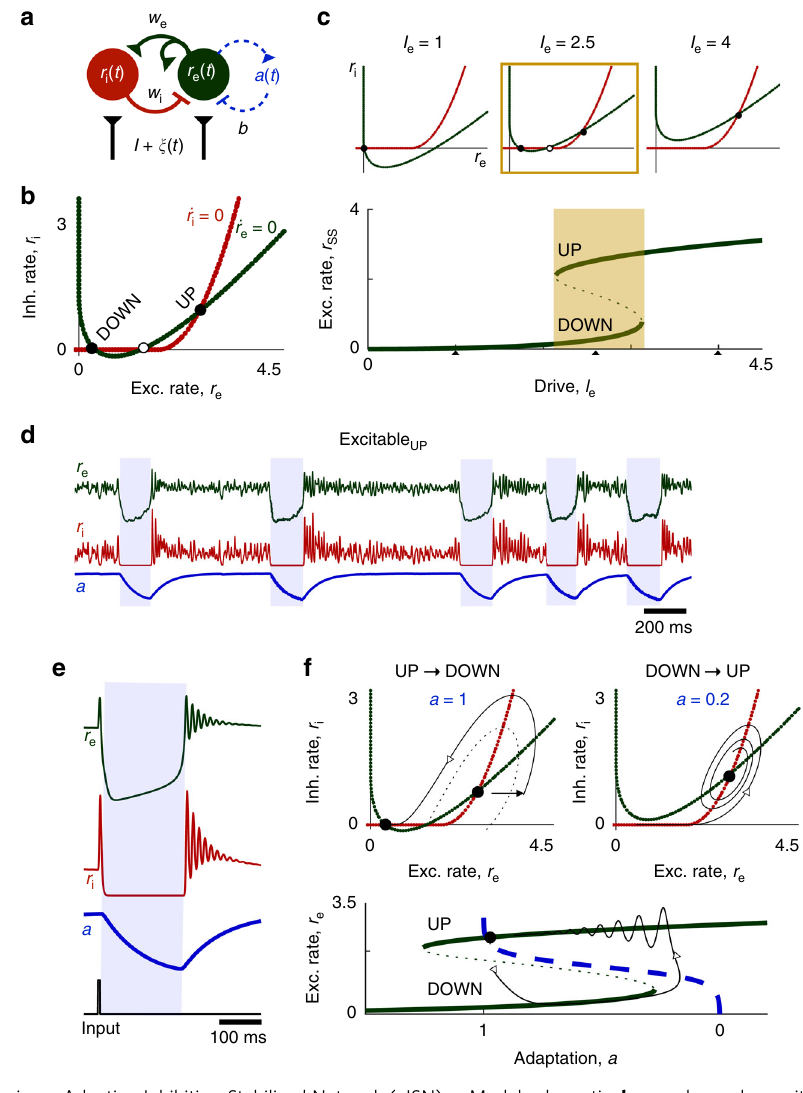
Fig. 6 UP/DOWN dynamics in an Adapting Inhibition-Stabilized Network (aISN). a Model schematic. b r e – r i phase plane with a frozen. c Bistability in the aISN with a frozen. Effective I/O curve of the excitatory population rate, r ss , with r e – r i phase planes at low, intermediate, and high levels of drive to the E population (Top). Parameters: w e = 4, w i = 3. d Excitable UP dynamics in the aISN. Parameters: τ e = τ i = 5 ms, τ a = 200 ms. e UP/DOWN transitions in the